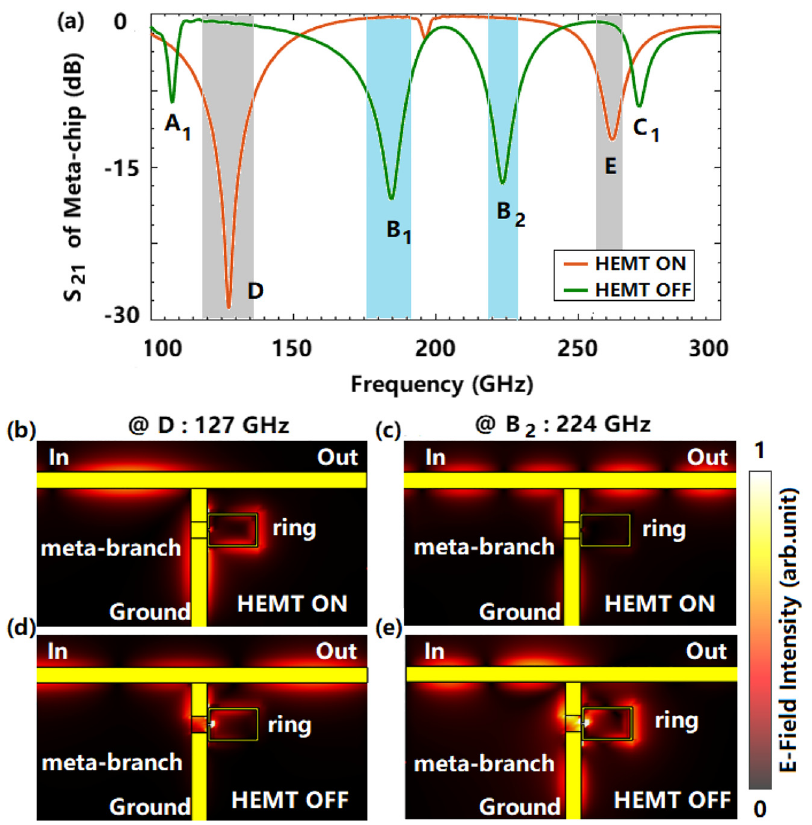
Figure 3: The spectra of S 21 of meta-chip and the fi eld contour maps at the “ ON/OFF ” points. (a) The amplitude spectra of the S 21 of the meta-chip; (b) to (c) The electric fi elds distribution of the meta-chip at points D and B 2 ,